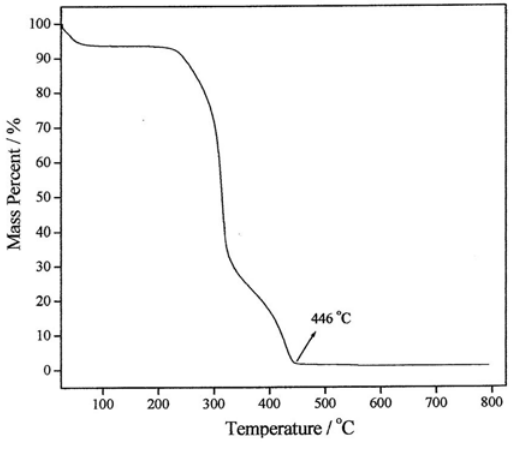
Fig. 1 – Thermogravimetric curve of fibers of the dried fruit of Luffa cylindrica